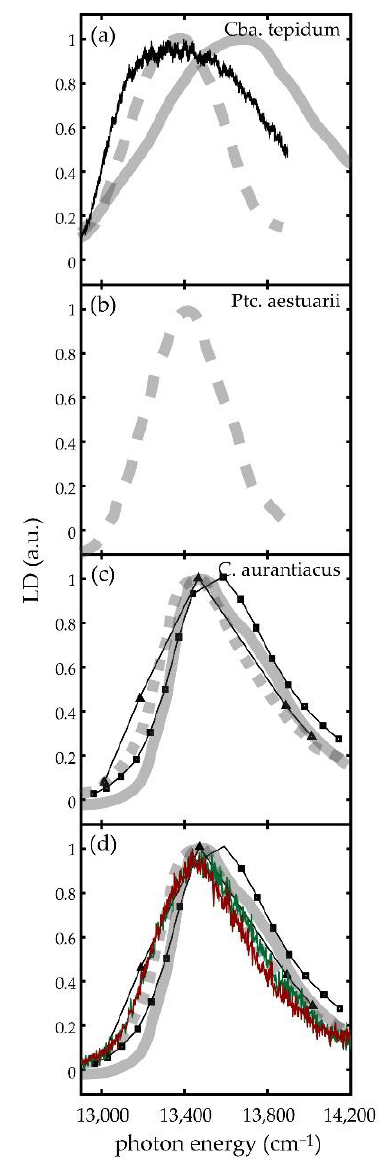
Figure 6. ( a ) Comparison of ensemble LD spectra from chlorosomes from the WT of Cba. tepidum. The noisy line (black) corresponds to the sum LD spectrum from 72 individual chlorosomes, the dashed line to the spectrum from [58], and the full line to the spectrum from ref [12]. ( b ) Ensemble LD spectrum from the WT of Ptc. aestuarii from [58]. ( c ) Ensemble LD spectra from the WT of C. aurantiacus . The spectra have been taken from [17–22,61] For better comparison all spectra have been normalized. ( d ) Same spectra as in ( c ) overlaid with the reconstructed ensemble spectra (method 1) for the bchR (green) and bchQR (red) mutants from Cba. tepidum . For facilitating this comparison, the widths of the reconstructed spectra have been multiplied by factor of 2.5, which gave the best agreement with the ensemble LD spectra from the WT of C. aurantiacus .